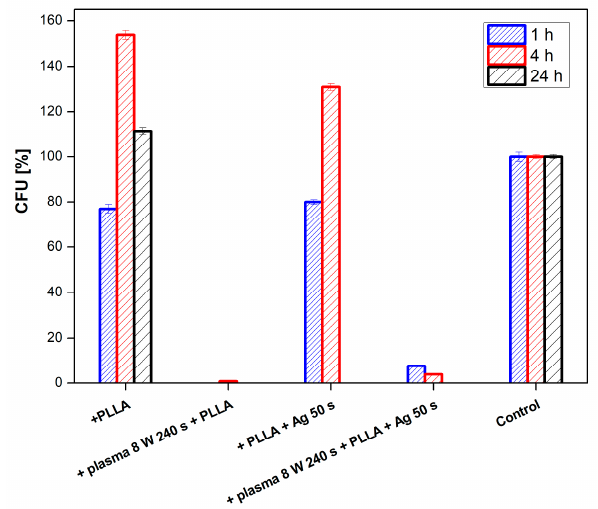
Figure 13. Results of antimicrobial tests for PTFE + PLLA using bacterial strain Proteus sp. for samples modified by plasma at 8 W for 240 s, and sputtered with Ag for 50 s.